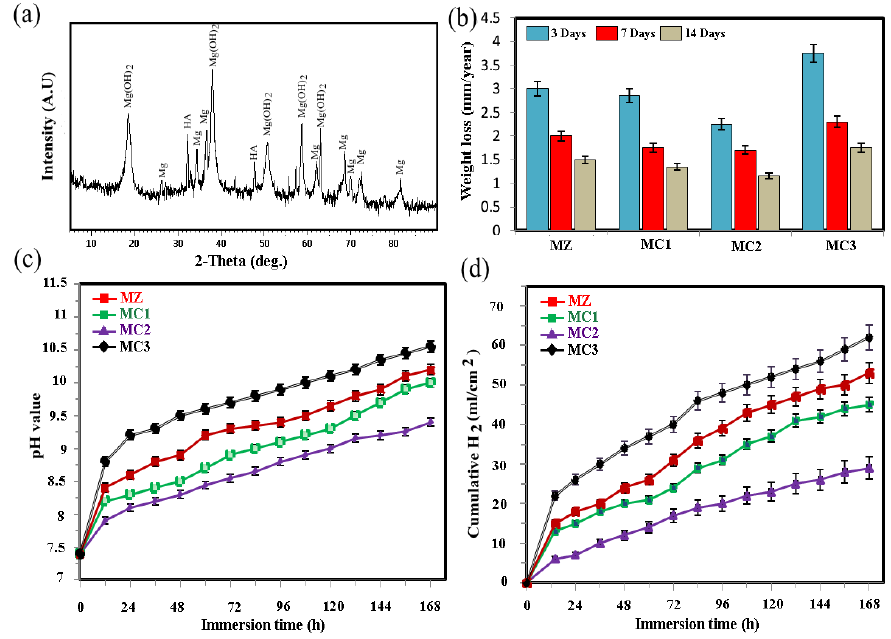
Figure 10. ( a ) X-ray diffraction patterns of MC2 after soaking in SBF for 7 days, ( b ) weight loss corrosion rate of MZ/CNTs nanocomposites in Kokubo solution for the durations of 3, 7 and 14 days, ( c ) pH value, ( d ) H2 evolution of MZ, MC1, MC2 and MC3 composites.